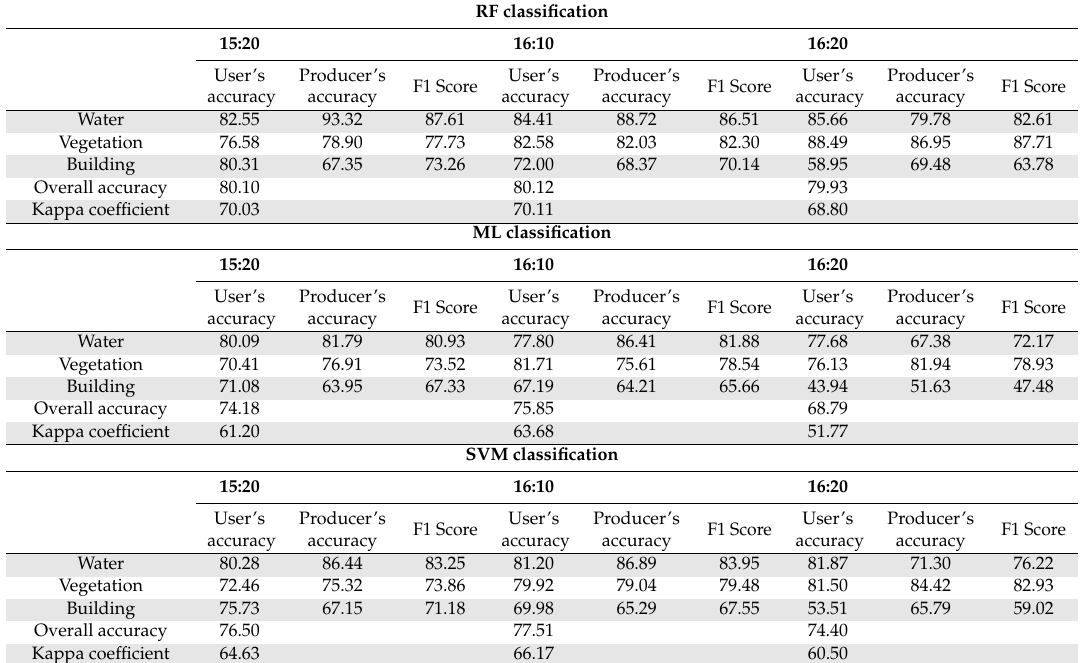
Table 2. Control point coordinates.